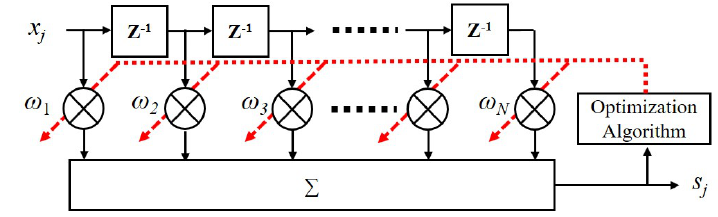
Figure 1. Schematic of an FFE with N